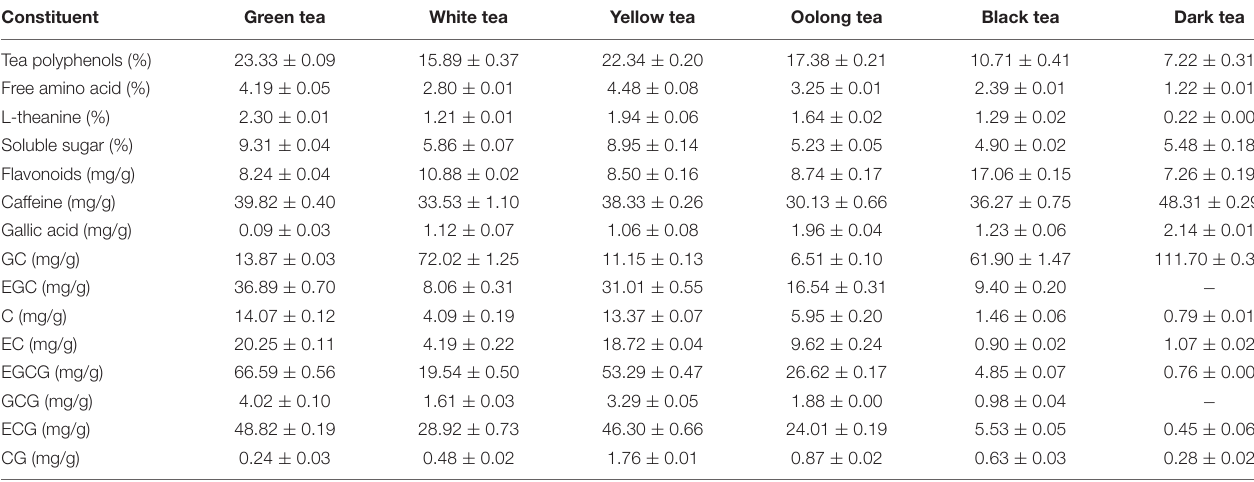
TABLE 1 | Analysis of the active components in six kinds of tea.